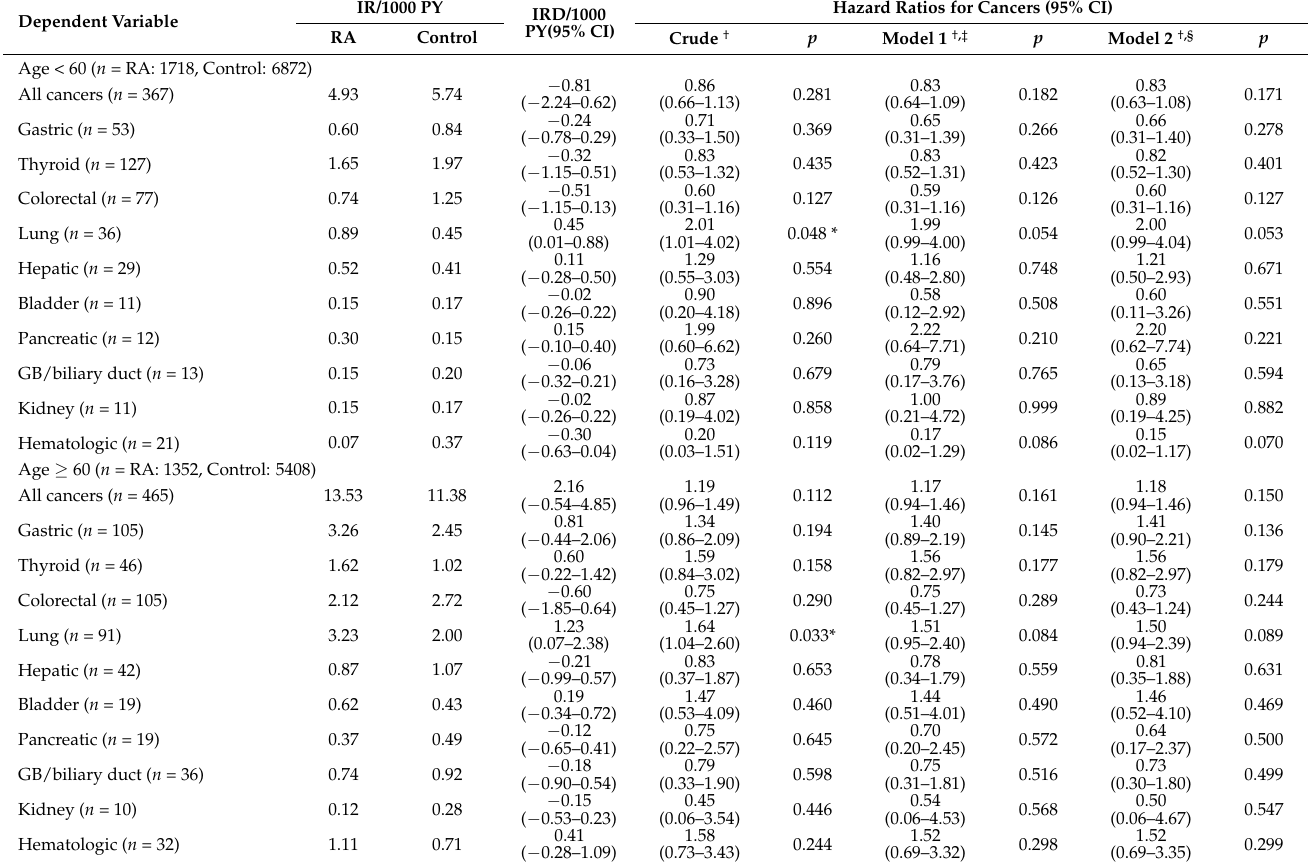
Table 4. Subgroup analysis of Crude and adjusted hazard ratios of RA for various cancers by